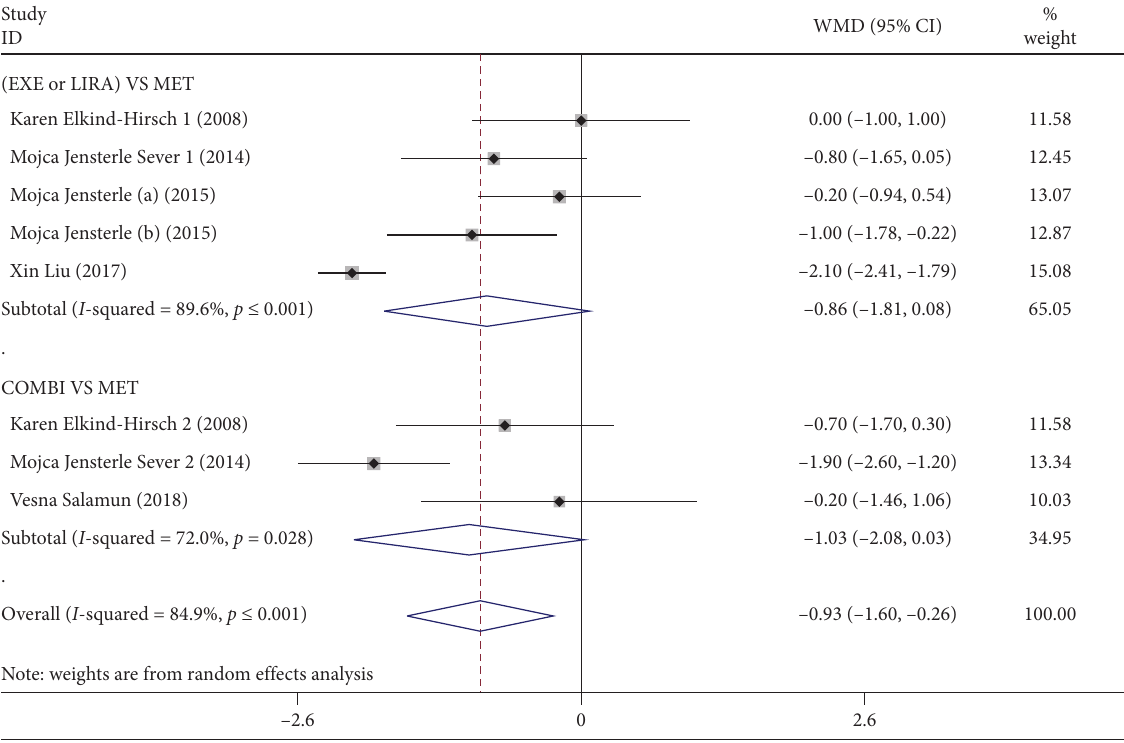
Figure 4: Forest plot of the outcome of BMI reduction effect in overweight/obese. PCOS patients. EXE: exenatide; LIRA: liraglutide; MET: metformin; COMBI: combination, represented GLP-1RAs combined with MET treatment; WMD: weighted mean